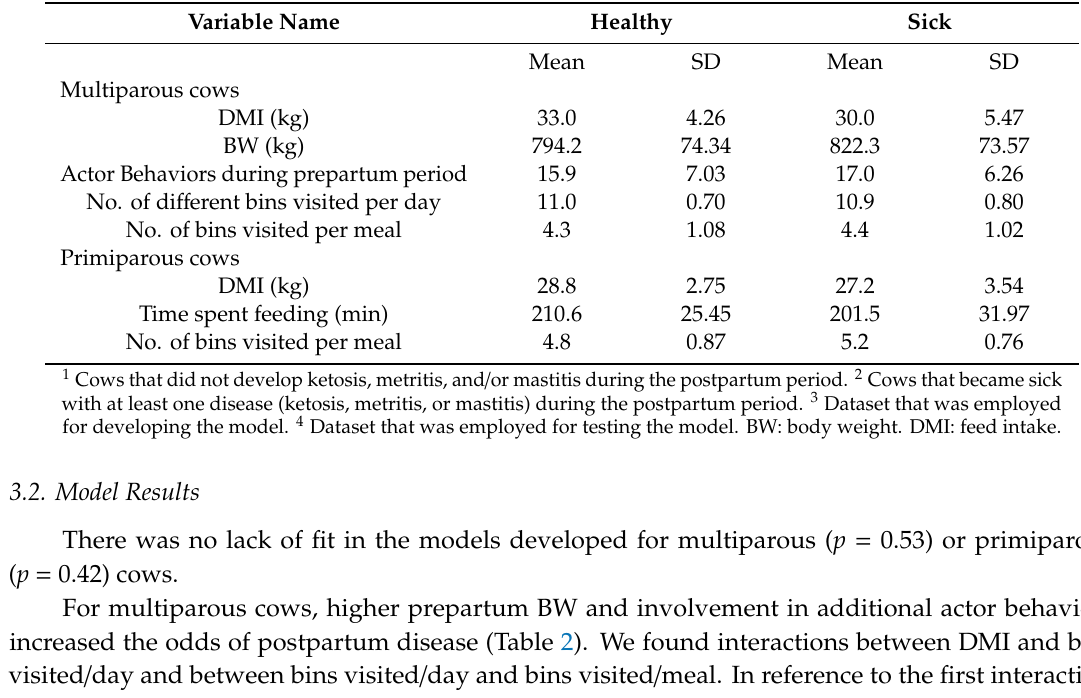
Table 1. Mean and SD of significant variables, shown separately for multiparous and primiparous cows, and by health status postpartum (i.e., healthy 1 or sick 2 with metritis, hyperketonemia (HYK), or mastitis). The data are for the combined training 3 and testing 4